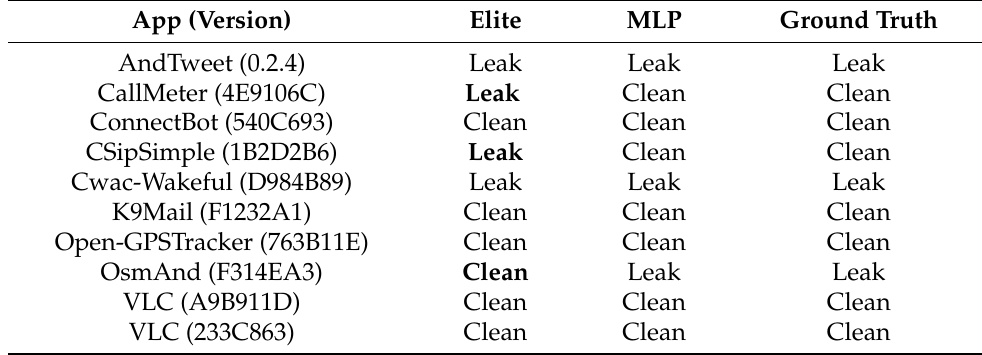
Table 7. Comparison with Elite